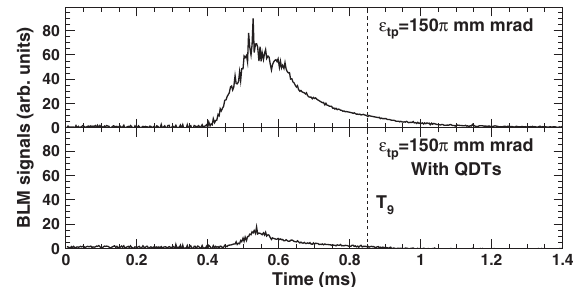
FIG. 16. Scintillation-type BLM signals over the first 1.4 ms measured in the collimator section with a beam intensity of 740 kW; (top) 150 π mm mrad transverse painting, and (bottom) 150 π mm mrad transverse painting with QDTs.